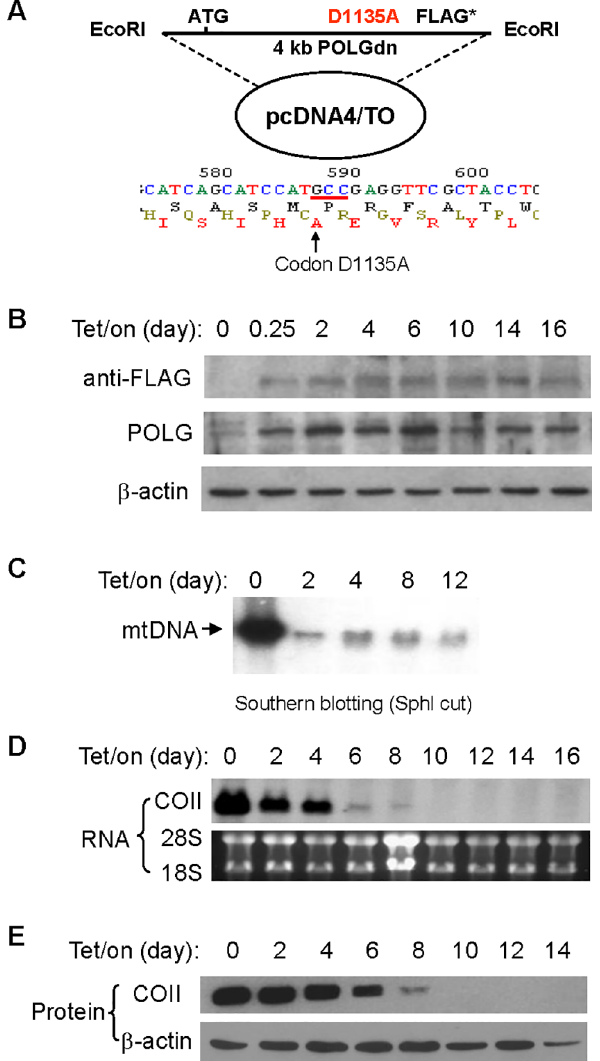
Fig 1. POLGdn expression led to the depletion of mtDNA-encoded respiratory chain components. (A) POLGdn-pcDNA4/TO construct and nucleotidesequencing analysisconfirming the D1135A mutation. (B) Inductionof POLGdn expressionby doxycycline. T-Rex293cells carrying POLGdn constructionwere incubatedwith doxycyclineat an indicatedtime point. POLGdn expressionwas detected by anti-FLAG antibody, whileboth the endogenousPOLG and POLGdn proteins were detected by anti-POLG antibody using Western blot assay. (C) Dramatic decreaseof mtDNA by expressionof POLGdn. Southern blot assay was used to measuremtDNA content. 10 µ g total cellularDNA (includinggenomicDNA and mtDNA) from each sample was digested with SphI to linealizethe circular mtDNA, followedby gel electrophoresis. 32 P- labeledmitochondrial COII DNA fragment was used as a probe to detect mtDNA. (D) Assay of mtDNA- encodedCOII RNA expressionby northernblot analysis. (E) Detection of mitochondrial DNA-encoded COII protein by Western blot